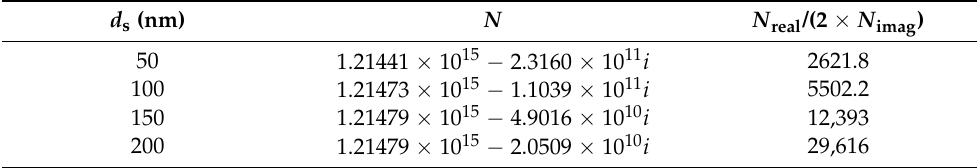
( b ) Figure 5. ( a ) Absorption spectra of designed structures under different chemical potentials μ c . ( b ) Effect of chemical potential μ c on the absorption efficiency at 1550.6 nm.